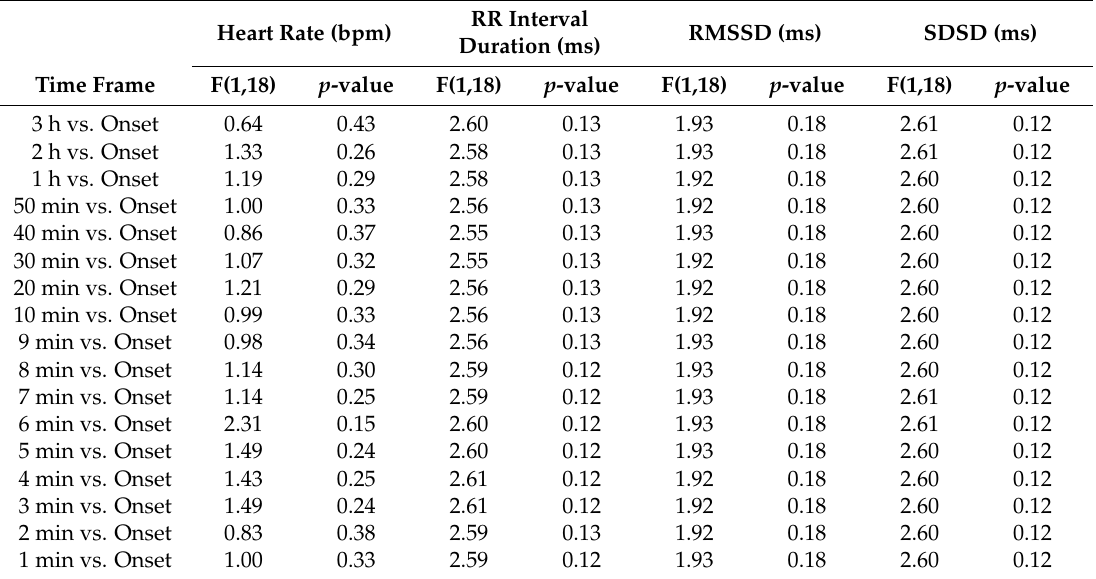
Table A3. Tabular summary of the repeated measures ANOVA conducted on the ECG features obtained from time-frames prior to SCA vs. during the onset of SCA ( n = 10).